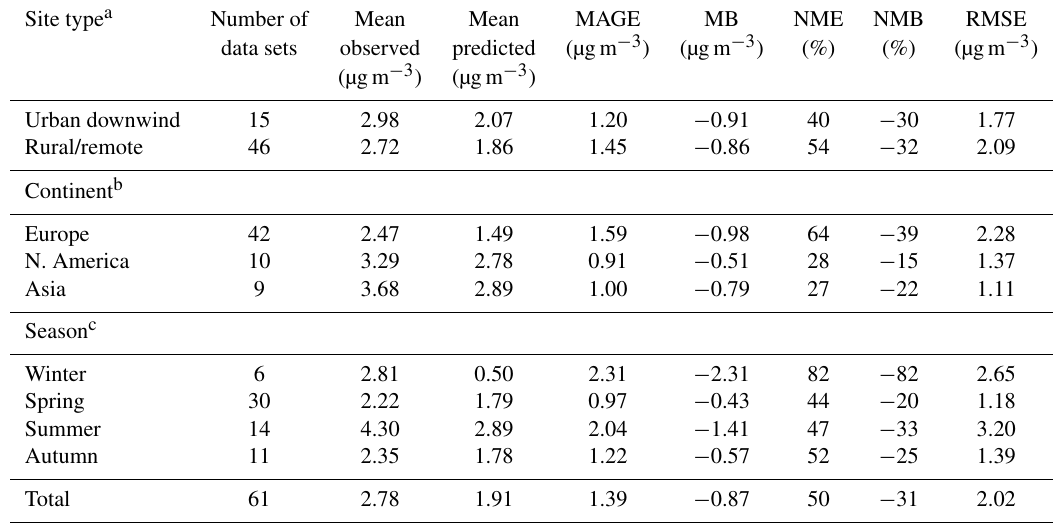
Table 4. Statistical evaluation of EMAC SOA against AMS OOA in the Northern Hemisphere during